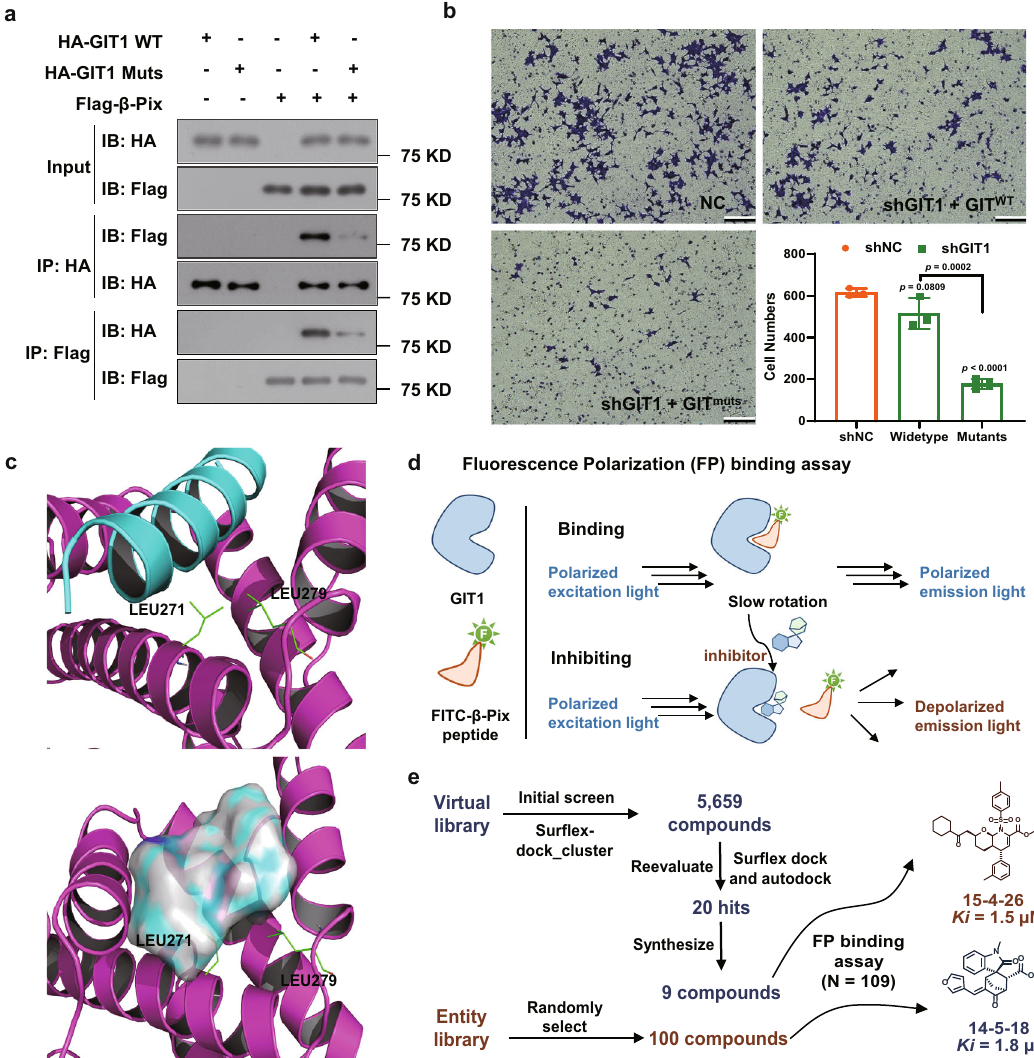
Fig. 2 | Screening methods to identify 14-5-18 and 15-4-26 as inhibitory mole- culesforGIT1/ β -Pixinteraction.a Co-immunoprecipitation(co-IP)experimentto detect the interaction between β -Pix and GIT1 in both the wild-type or mutant forms. HA-GIT1(wide-typeand mutant forms) and Flag- β -Pix weretransfected into HEK-293T and the cell lysates were collected to perform the co-IP assay. The demonstrated blots were representatives from three independent experiments with similar results. b Transwell invasion assay to detect the invasion abilities of MKN45 cells with GIT1 wide-type or mutants ( n =3 biologically independent sam- ples). Scale bar=100 µ m. c Cartoon model showing the interaction of GIT1 (magenta) and the key peptide β -Pix (cyan). Key residues Leu271 and Leu279 were